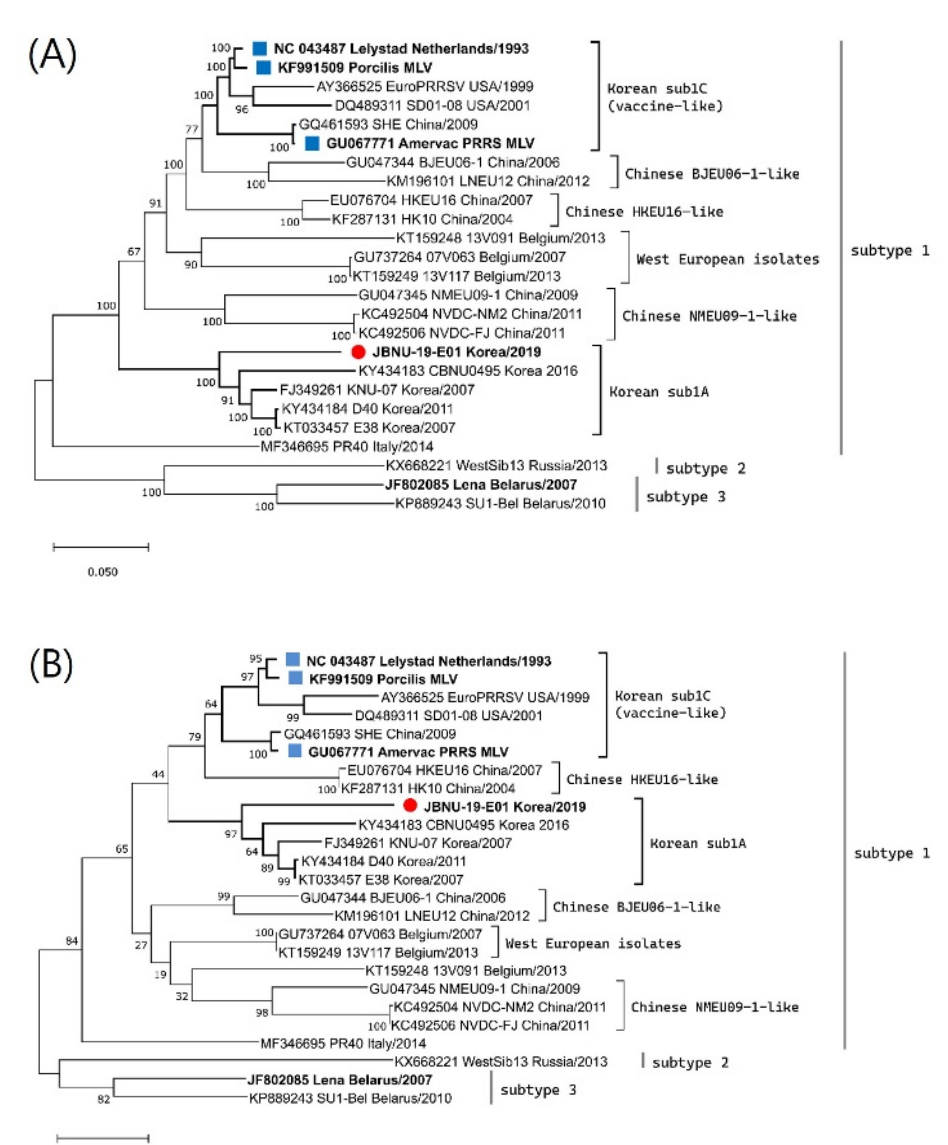
Figure 1. Phylogenetic trees of PRRSV1 ( A ) whole genome and ( B ) ORF5 sequences using the maximum likelihood method based on the generalized time-reversible (GTR) model with G + I in MEGA X. Bootstrap values were calculated with 1000 replicates. The isolate newly sequenced in this study was marked with a red circle, while the prototype (Lelystad) and vaccines were marked with a blue square.